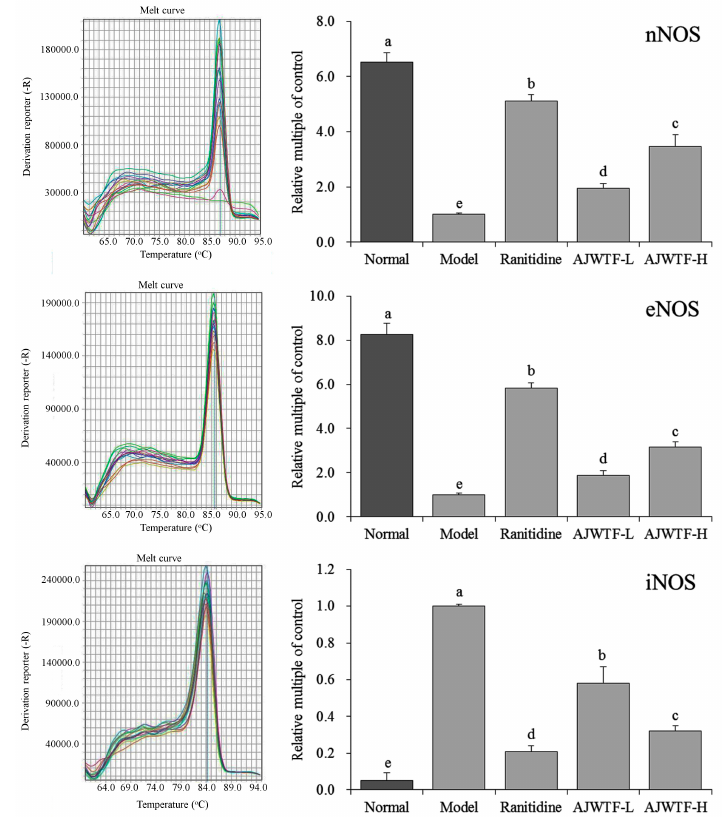
Figure 3. Messenger RNA expression of neuronal nitric oxide synthase (nNOS), endothelial nitric oxide synthase (eNOS), and inducible nitric oxide synthase (iNOS) in the stomach tissues of mice from each group. Values presented are the means ± standard deviation. a–c Mean values with different letters in the same bars indicate significant difference ( p < 0.05) according to Duncan’s multiple-range test. Ranitidine: Ranitidine at 50 mg/kg body weight (b.w.) by gavage; AJWTF-L: Anji white tea flavonoids at 100 mg/kg b.w. by gavage; AJWTF-H: Anji white tea flavonoids at 200 mg/kg b.w. by gavage.